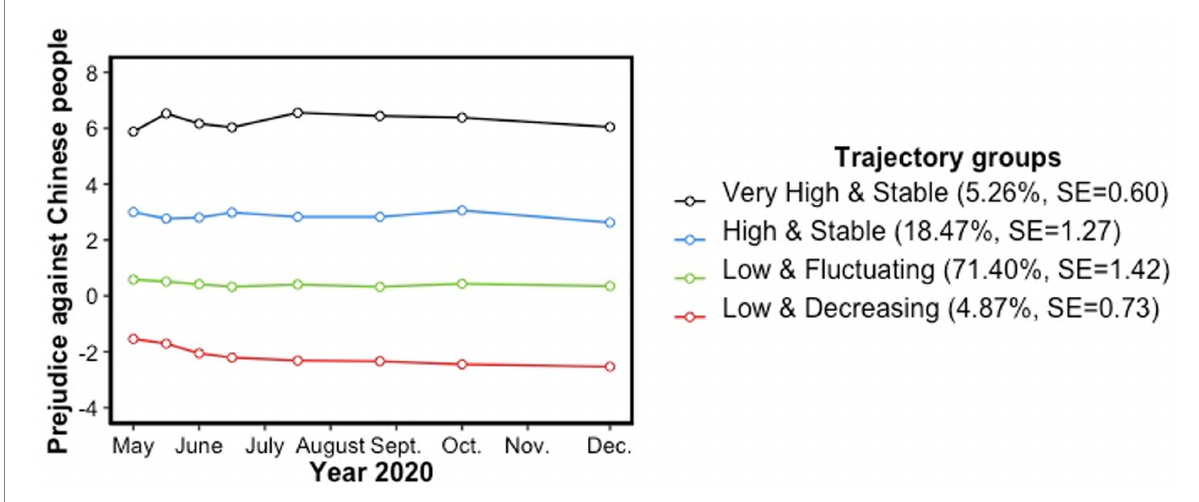
FIGURE 1 Trajectory groups of prejudice against Chinese people.